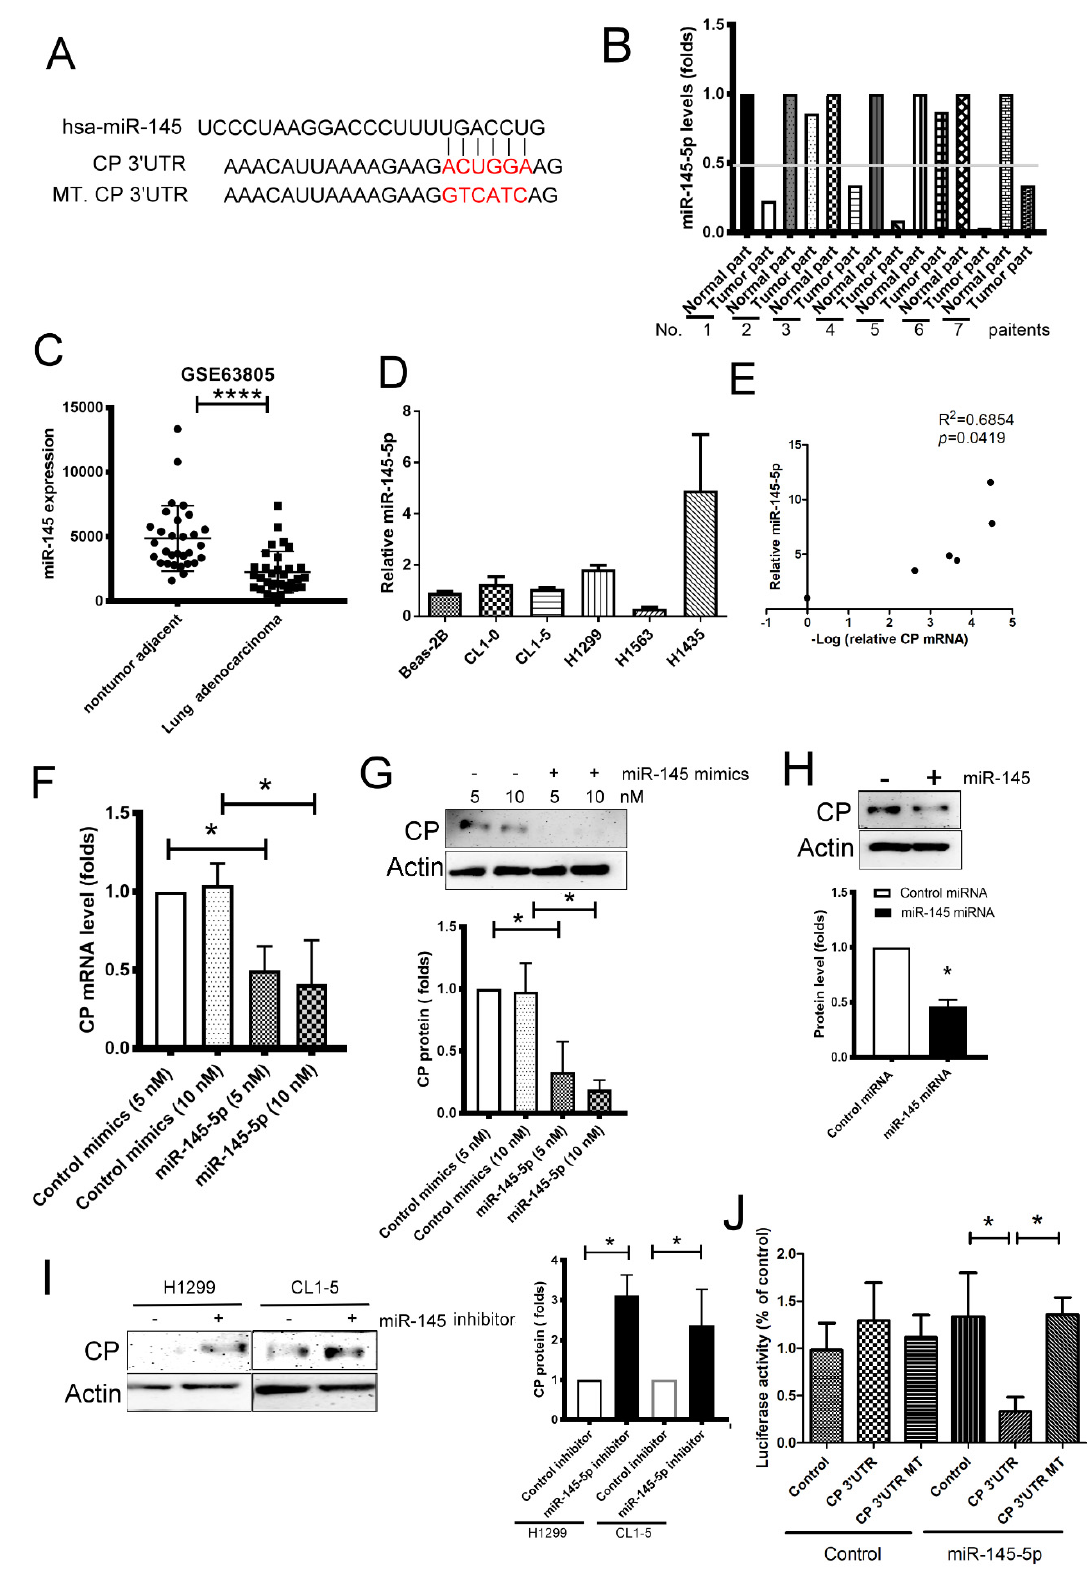
Figure 4. Loss of miR-145-5p contributes elevated CP protein in lung cancer. ( A ) The predicated binding site of miR-145-5p on the 3’untranslated region (UTR) of CP mRNA. ( B ) Downregulated miR-145-5p in tumor of 7 lung cancer patients. ( C , D ) The expression of miR-145-5p in lung cancer patients (GSE63805, 30 non-tumor adjacent tissue; 32 lung adenocarcinoma) and lung cancer cell lines. ( E ) The correlation of miR-145-5p and CP protein in Beas-2B cells and lung cancer cells lines. ( F,G ) miR-145- 5p mimics decreased CP mRNA and protein expression in H1563 cells. ( H ) Overexpression of miR-